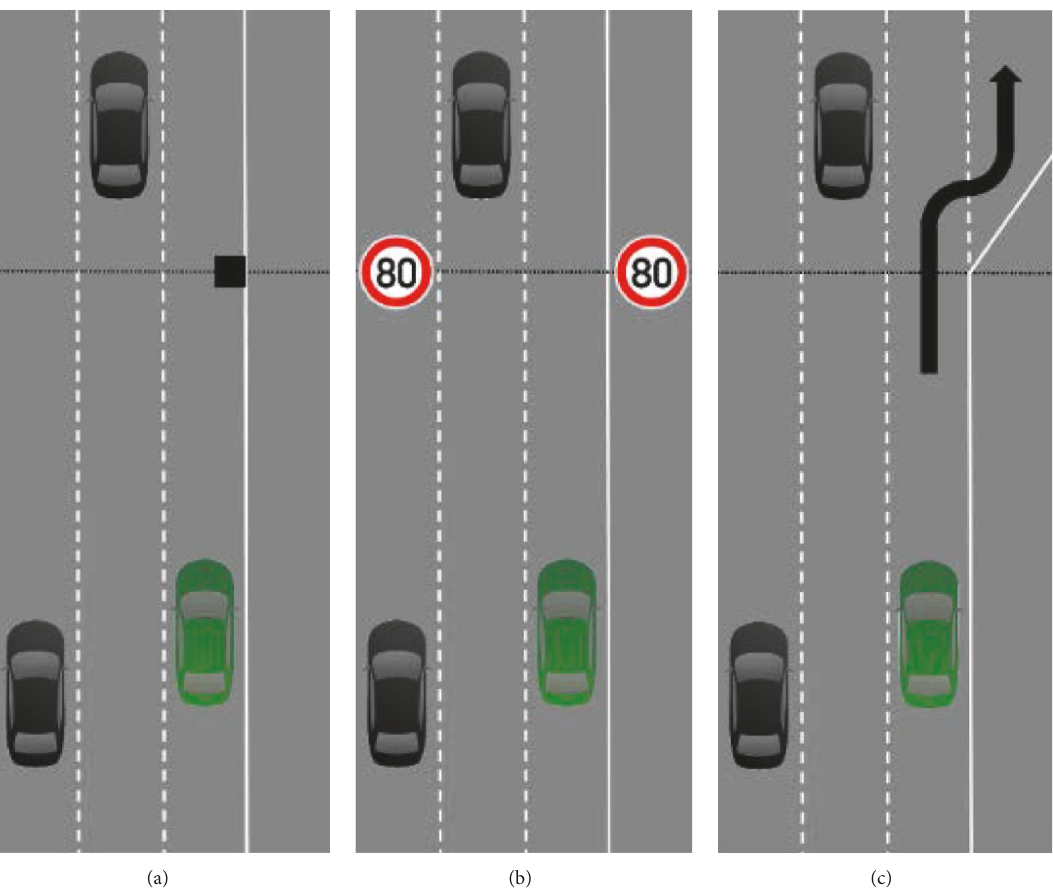
Figure 4: Schematic bird’s eye view perspective of the interaction scenarios “avoidance” (a), “speed limit” (b), and “lane change” (c). The host vehicle is displayed in green. Black horizontal line in each scenario indicates execution of maneuver.